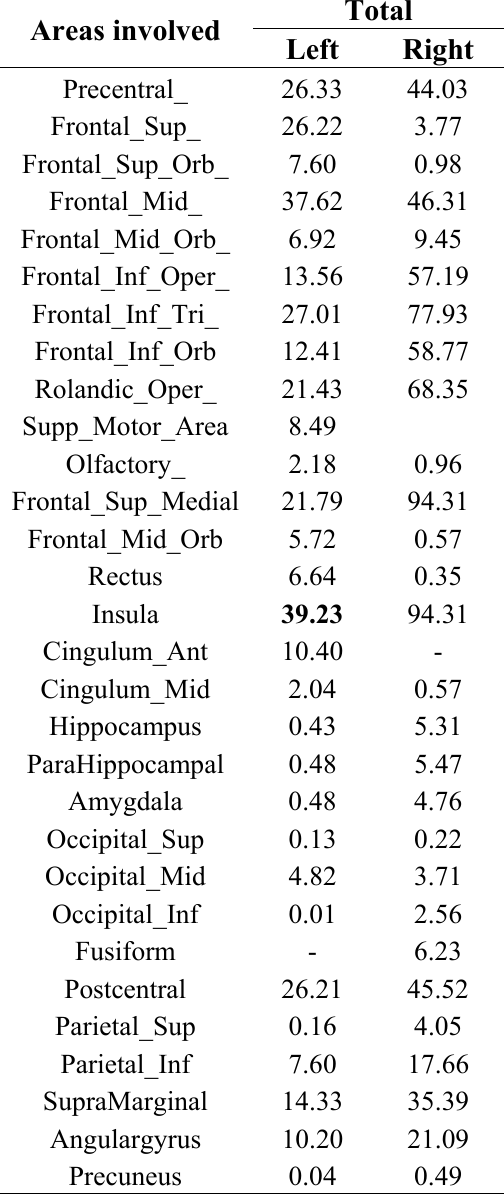
Table 5. Number of voxels involved in lesions in LBD and RBD patients. Areas of major overlapping are reported in